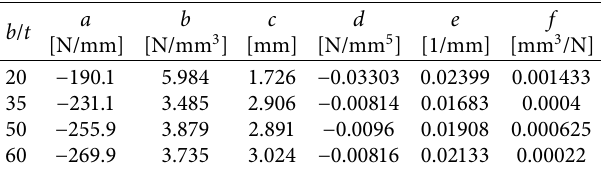
Table 6: Coefficient of equation (3) of outstand compressed